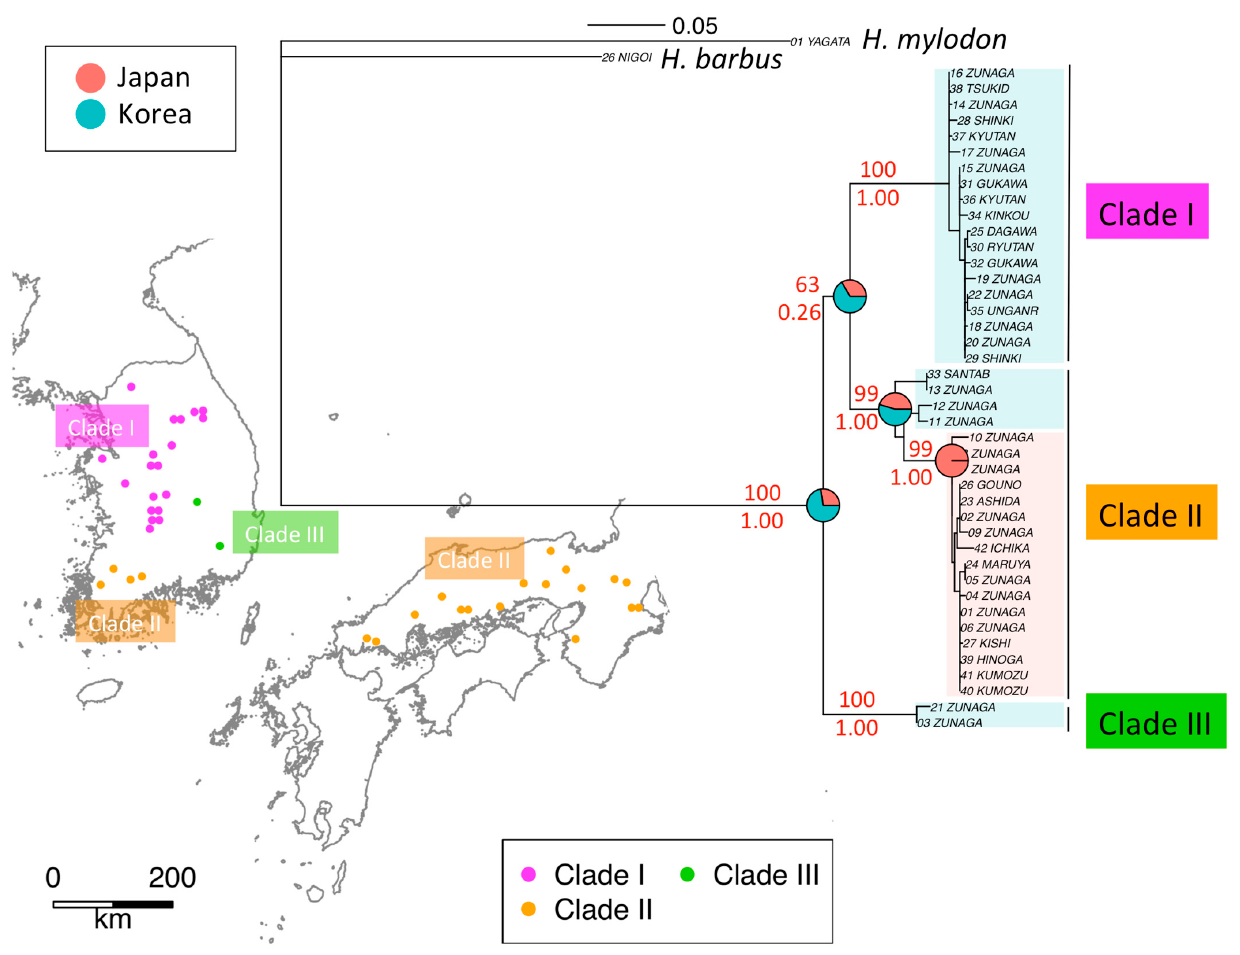
Figure 3. Phylogenetic trees of ND2 sequences and geographic locations of H. longirostris reconstructed from ND2 sequences. Red numbers in the phylogenetic tree indicate bootstrap probabilities (%) on the top and posterior probabilities on the bottom. Pie charts on the phylogenetic tree represents the Bayesian assignment of ancestral nodes to Japan and Korea.